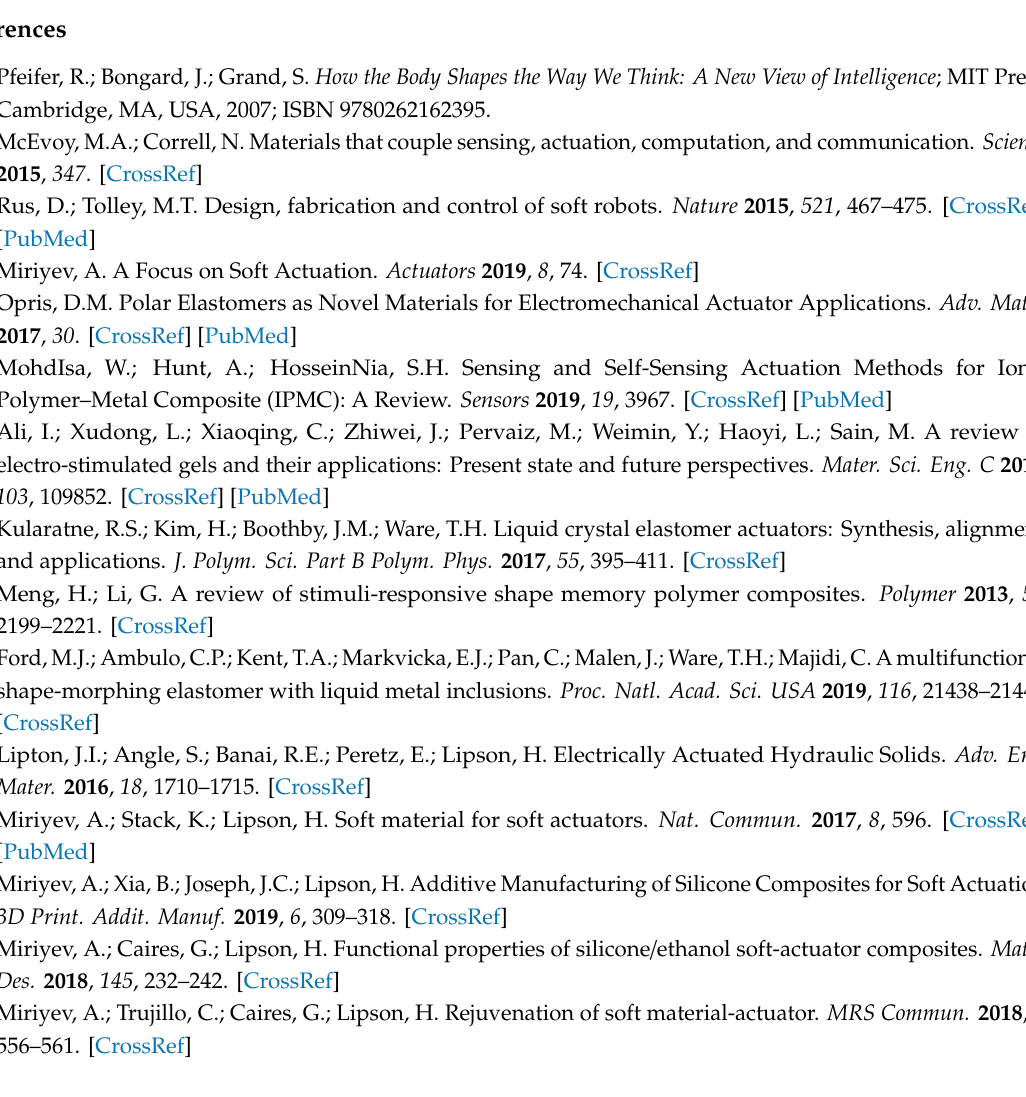
Figure A7. A comparison of actuation force prediction using the LSTM model, dense baseline model, and simple linear regression model.